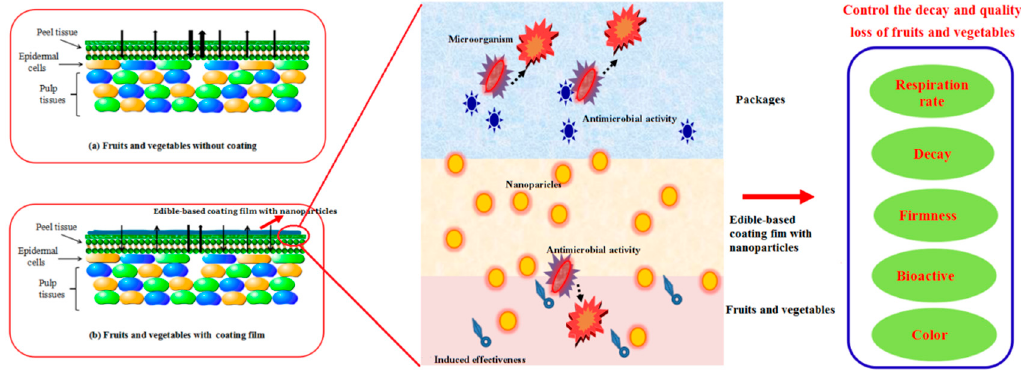
Figure 6. Preservation mechanism of ECF (such as CS coating film) with NPs on the quality of